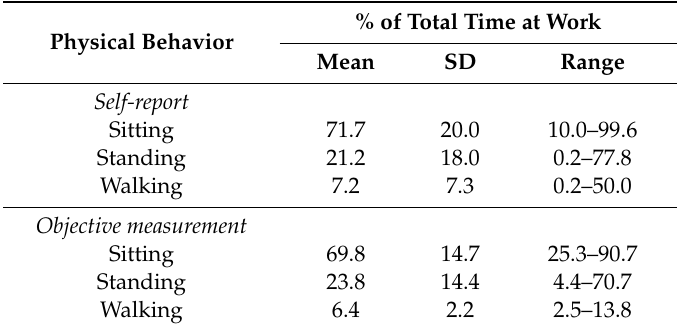
Table 2. Time spent in physical behaviors at work according to self-reports and objective measurements ( n = 98).